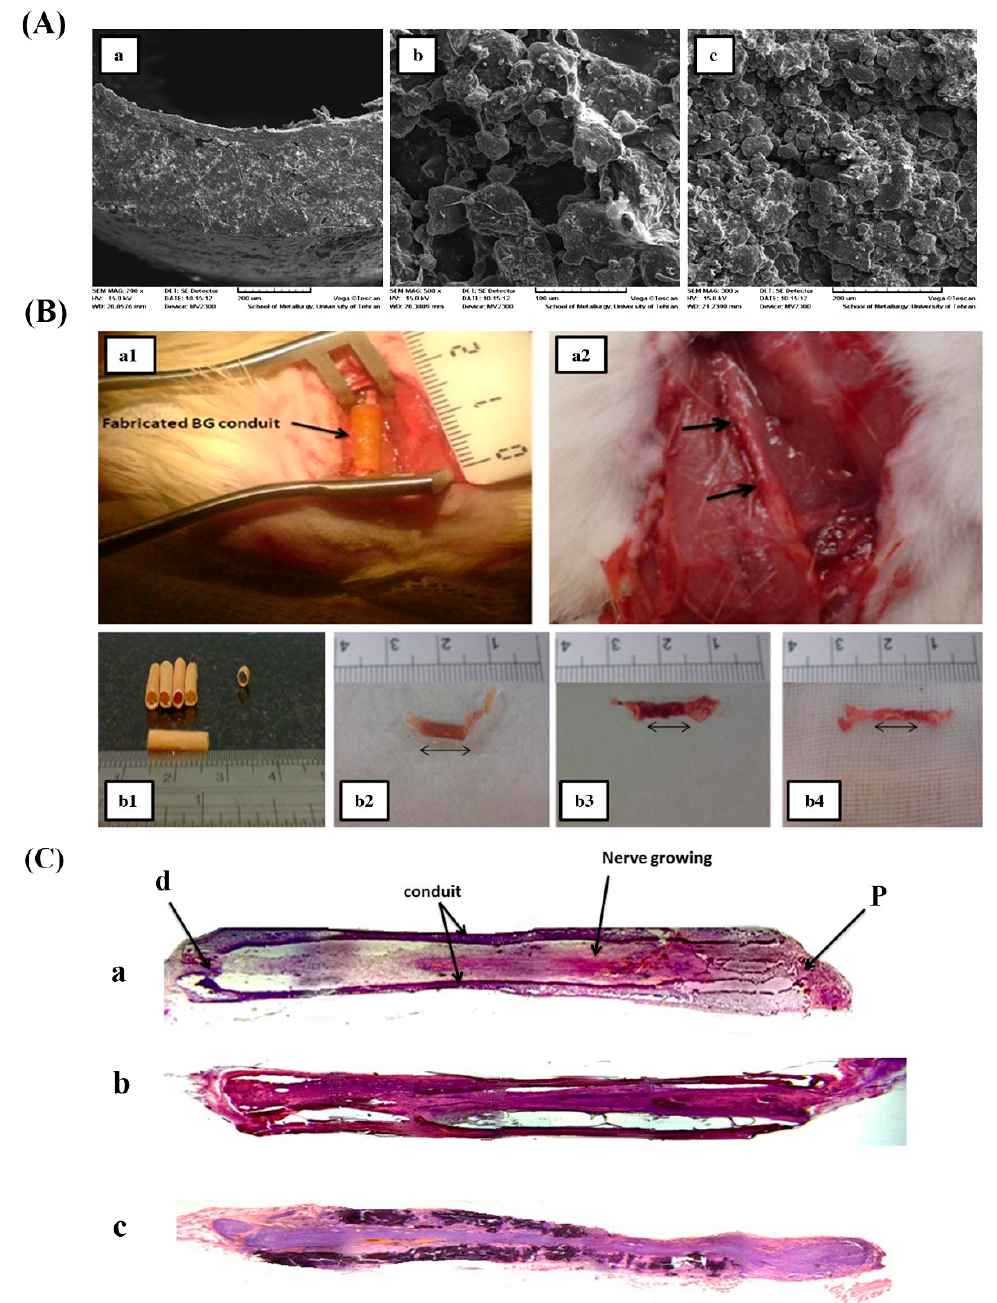
Figure 2. ( A ) SEM micrographs of the nano 45S5 Bioglass / gelatin conduits; cross-sectional view of the composites (200 × ) (a), outer layer of the conduit wall (500 × ) (b), and its inner layer (300 × ) (c). ( B ) The illustration (a1) shows the implantation process of nerve conduits made of 45S5 nano-Bioglass / gelatin into a 10 mm long gap defect in the sciatic nerve in rats and (a2) and a macroscopic image of the regenerated nerve at 3 months post-surgery. (b1) shows nano Bioglass / gelatin conduits prior to the implantation and (b2), (b3), and (b4) represent the conduits at 30, 60, and 90 days post-implantation. ( C ) Histological longitudinal section of the implanted conduits at 30 (a), 60 (b), and 90 (c) days post-surgery, confirming the nerve outgrowth from proximal (P, right) to distal (d, left) ( × 10). Reproduced with permission from ref [20].